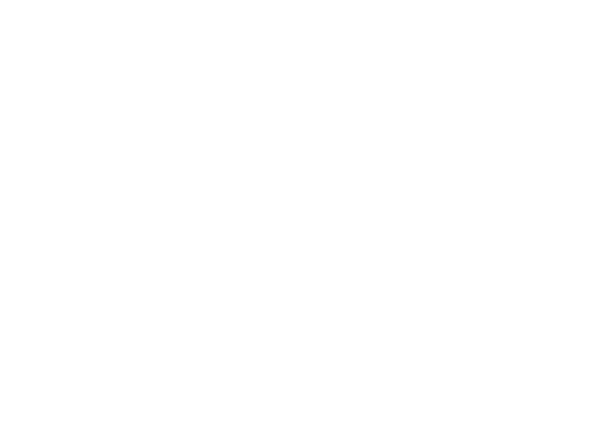
Figure 4. Cardiac ALDH2 activity in diabetic ALDH2*2 mutant mice exhibiting HFpEF with vehicle, EMP, Alda ‐ 1 and EMP + Alda ‐ 1 treatments. Cardiac ALDH2 activity data of non ‐ diabetic control ALDH2*2 mutant mice (Ctrl.), vehicle ‐ treated ALDH2*2 mutant diabetic mice (V), EMP ‐ treated ALDH2*2 mutant diabetic mice (E), Alda ‐ 1 treated ALDH2*2 mutant diabetic mice (A) and EMP and Alda ‐ 1 combinedly treated ALDH2*2 mutant diabetic mice (E + A) were shown. Data are presented as mean ± standard error of the mean (SEM). * p < 0.05, ** p < 0.01 and *** p < 0.001 refer to the difference between individual groups as shown. n = 4.